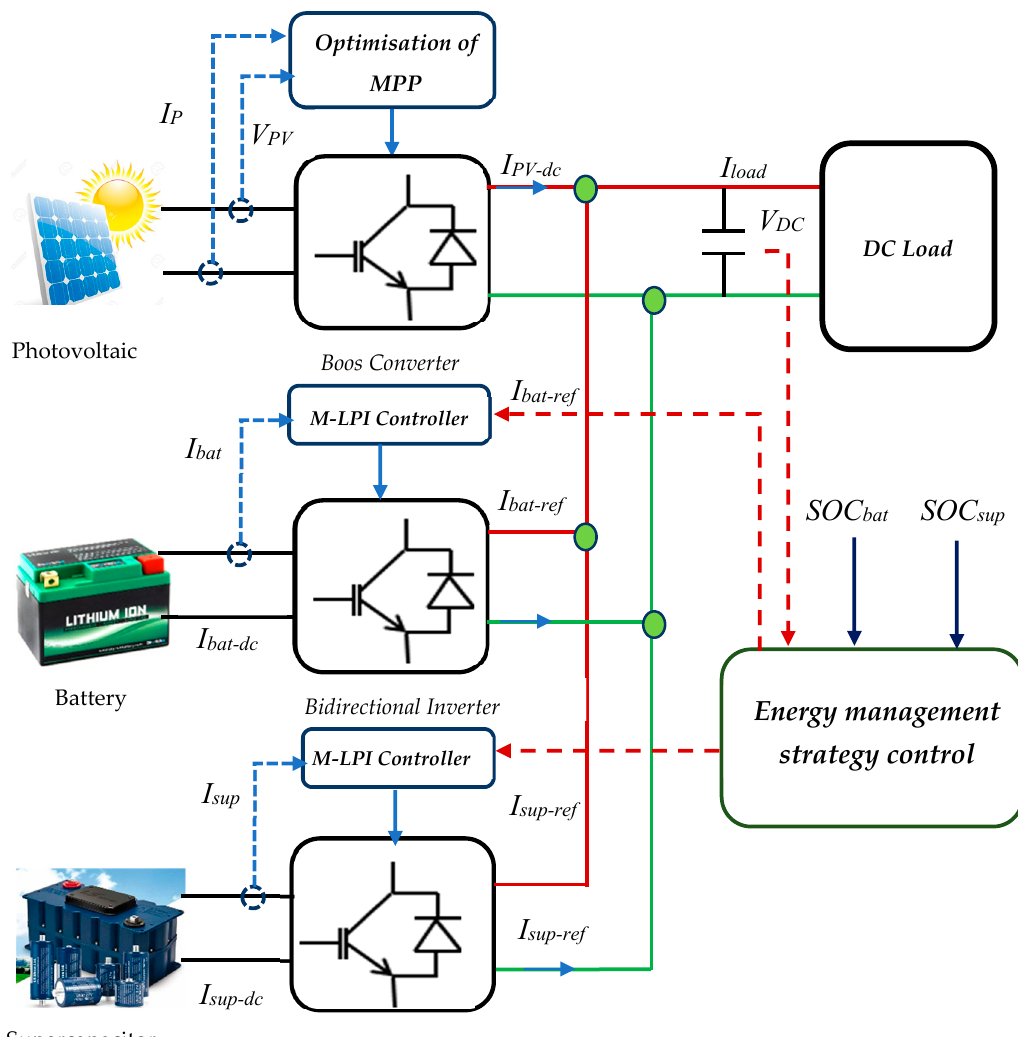
Figure 1. Microgrid photovoltaic storage system configuration.